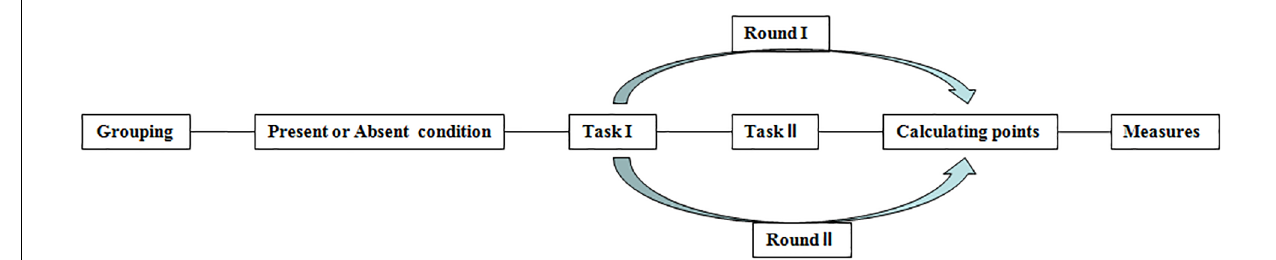
FIGURE 1 | The procedure of study 1. TABLE 1 | Matrix Types B: MD vs. MIP/MJP, the allocation from the view of a member of Group O. Points to Member S of Group O